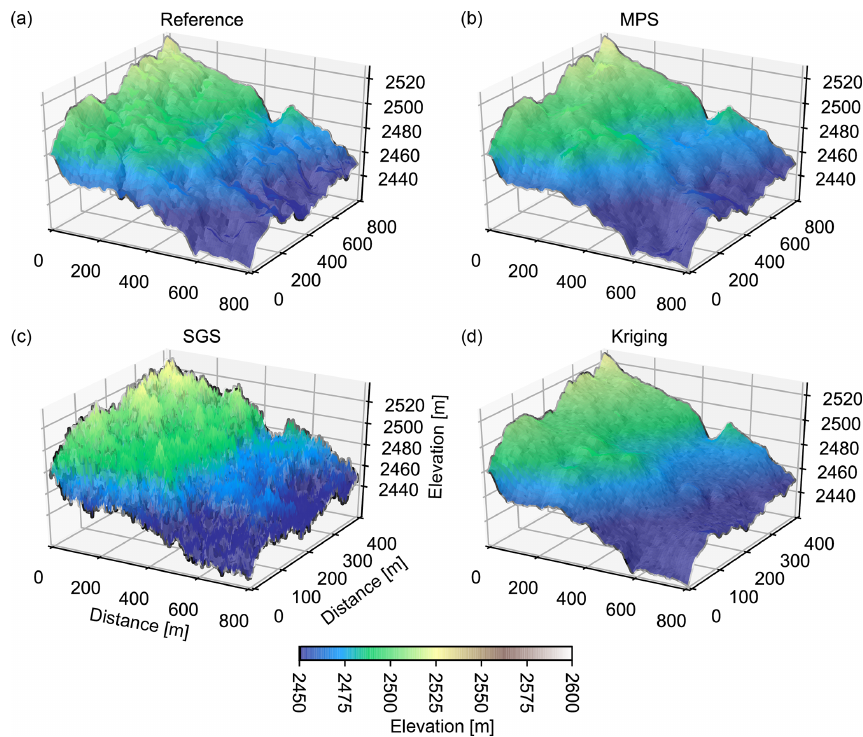
Figure 5. A 3D view of topographic interpolation from the synthetic test case. The color corresponds to the simulated elevation. Panel (a) presents the reference topography of the test case. (b) A MPS simulation, (c) a SGS simulation, and (d) a corresponding kriging estimate. The roughness is overestimated with the SGS and underestimated with the kriging estimation. MPS simulations provide an acceptable compromise between the method and produce realistic